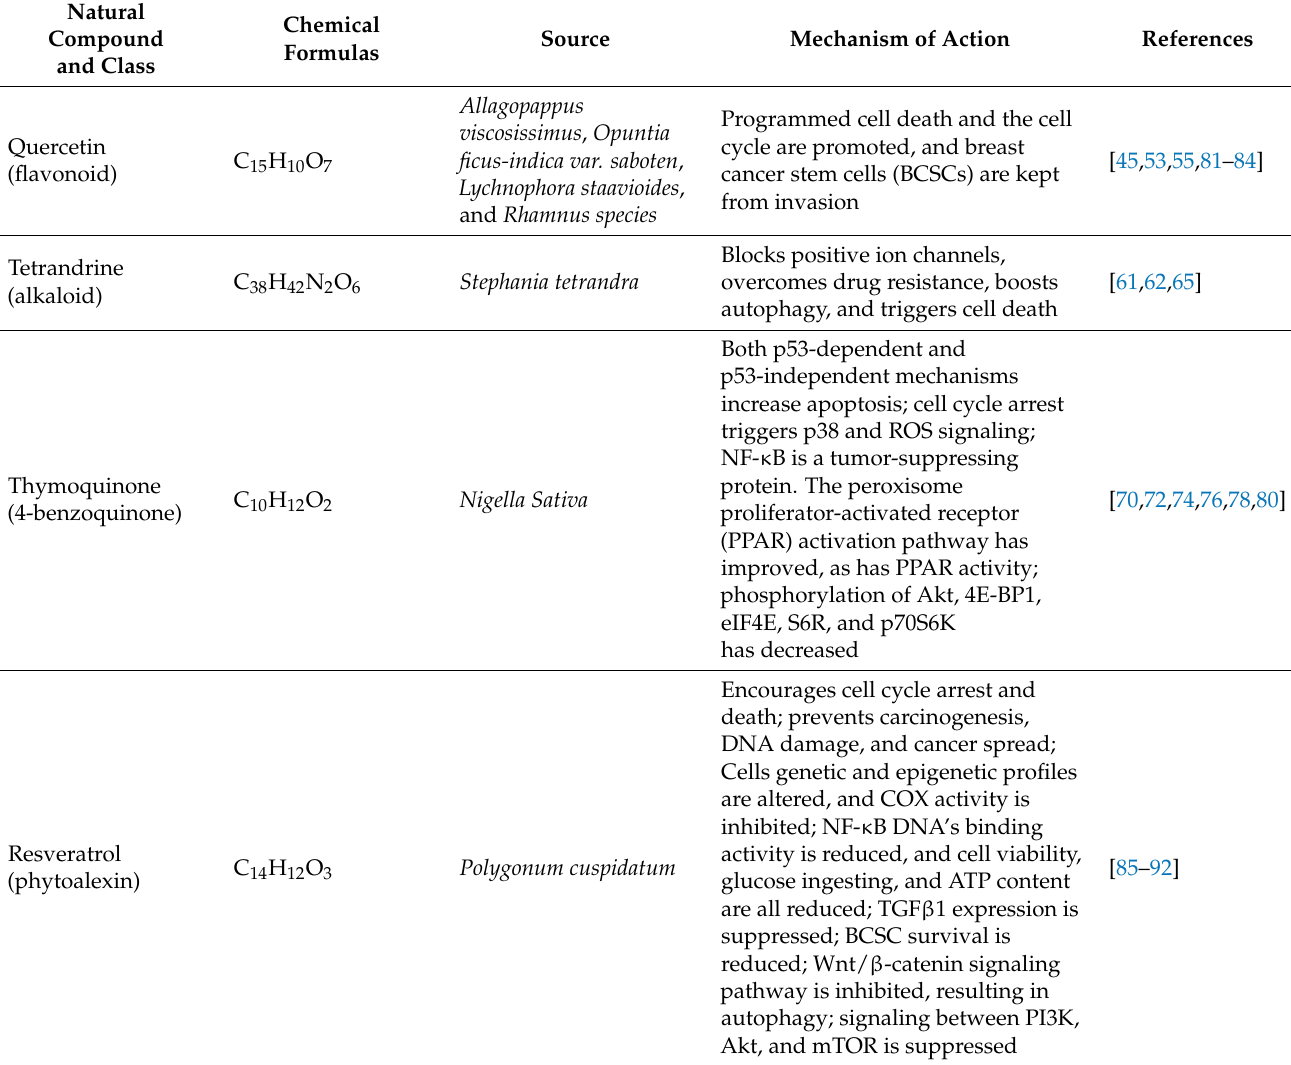
Table 1. The efficacy of natural compounds in the treatment of